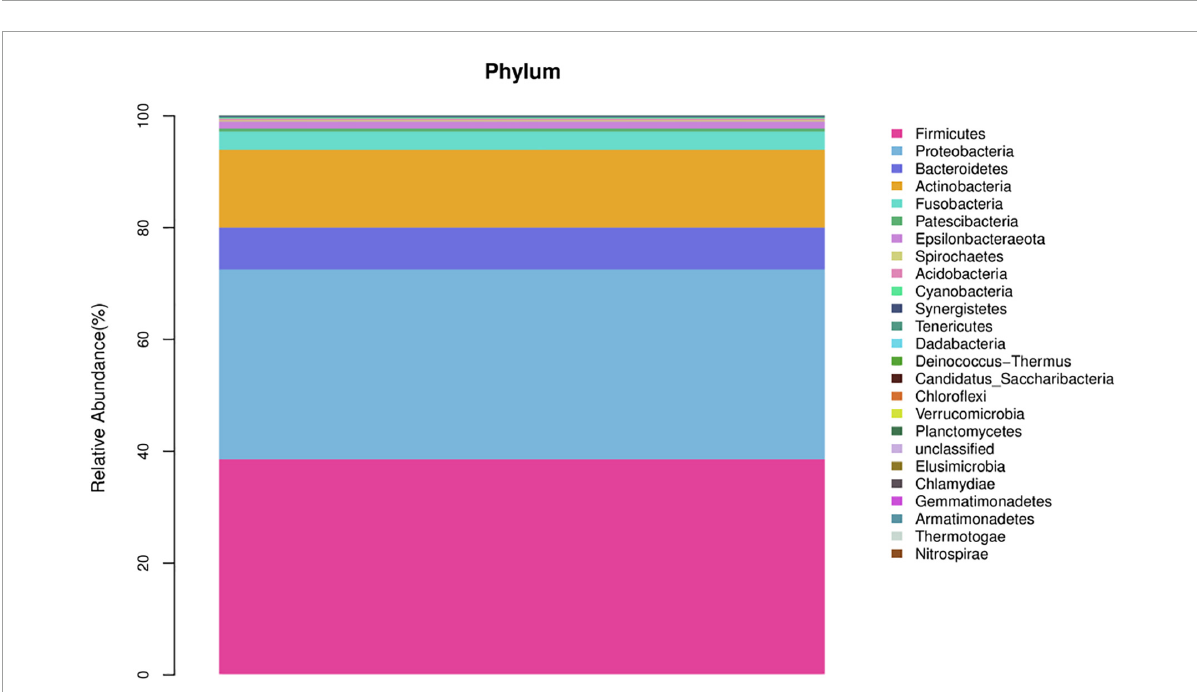
FIGURE3 Composition of airway microbiota in the acute exacerbation of chronic obstructive pulmonary disease (AECOPD)